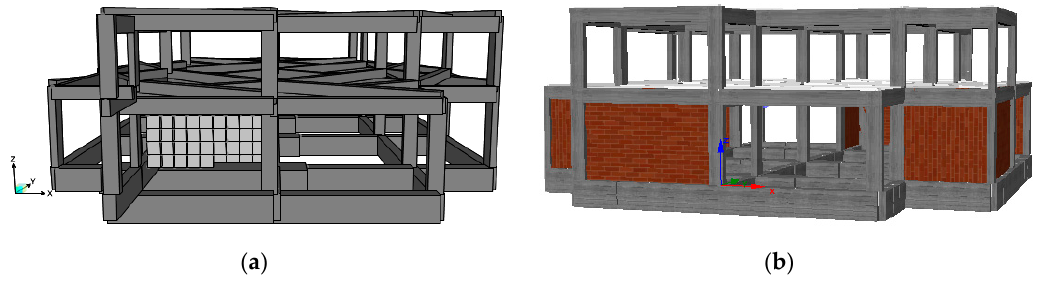
Figure 4. Structure modeled with SAP2000 ( a ) and SeismoStruct ( b ).